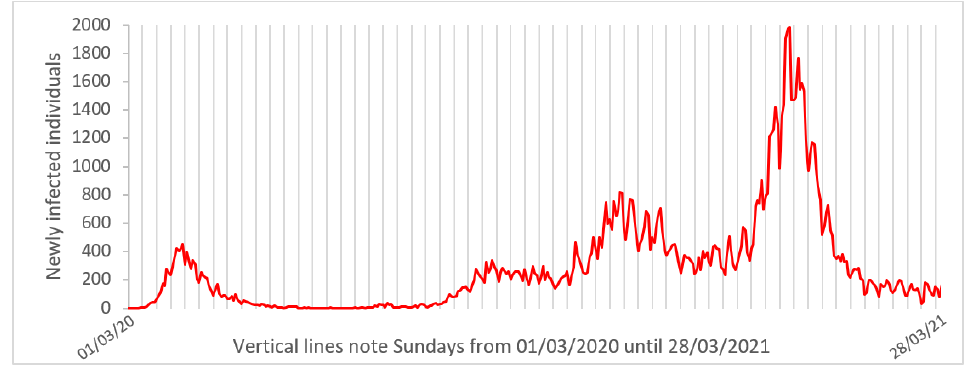
Figure 1. Daily count of newly infected individuals in Galicia since the beginning of the pandemic (raw data). Vertical grid lines separate each week and note Sundays to point out the “weekend effect”: most of them correspond to local minima in daily new infected values.